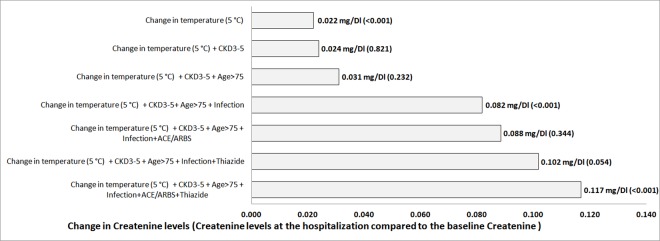
The cumulative increase in serum creatinine (mg/dL) for the addition of each clinical characteristic.The additional p value for each parameter is presented in brackets. ACE/ARBs—angiotensin-converting-enzyme inhibitor or angiotensin receptor blockers, CKD–chronic kidney disease